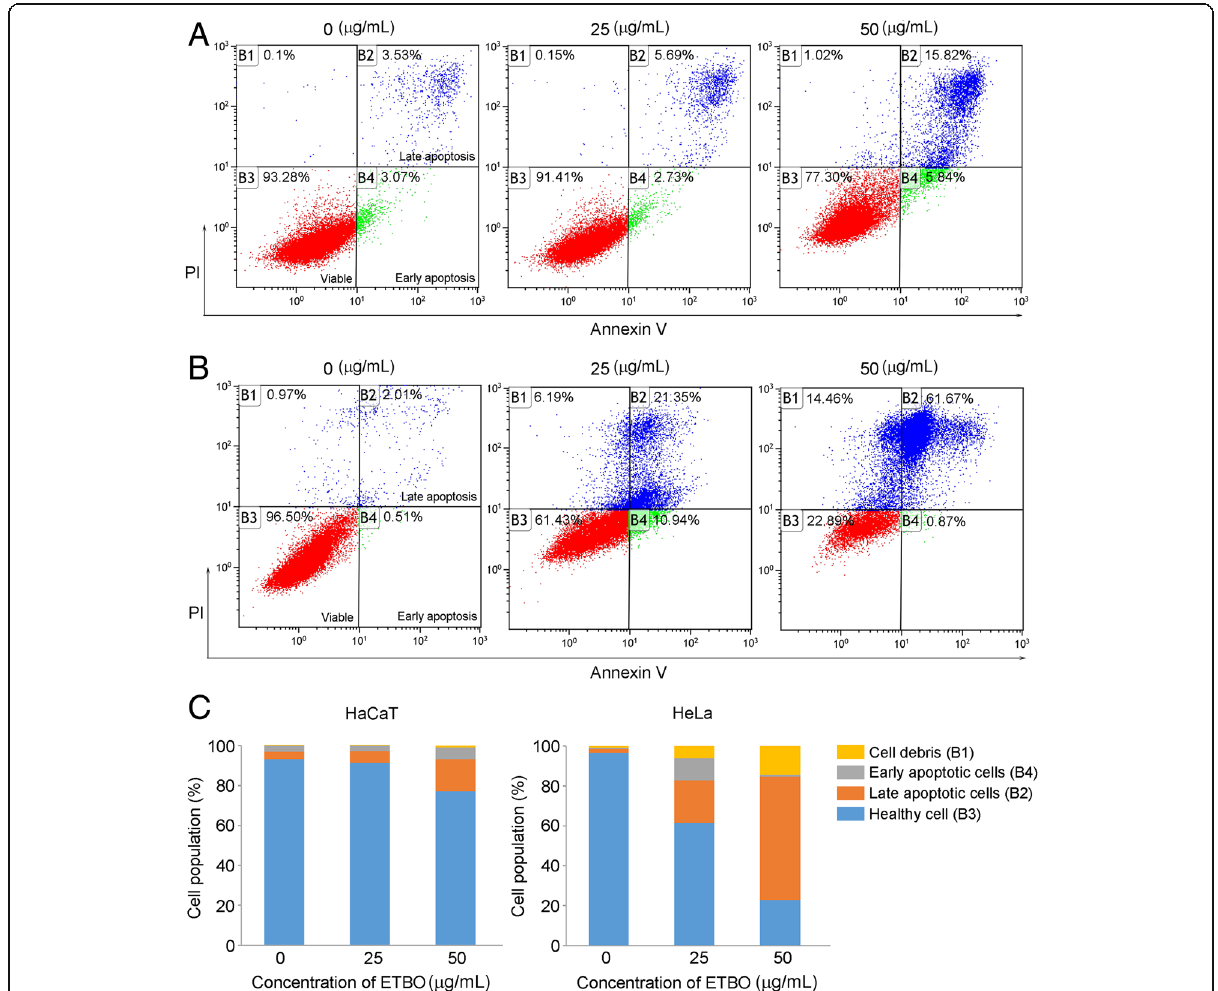
Fig. 4 Effect of ETBO on apoptosis. Normal (HaCaT) ( a ) and cancer (HeLa) cells ( b ) were treated with or without different concentrations (25 and 50 μ g/mL) of ETBO for 24 h. Cell population and the extent of apoptosis were measured by FACS analysis ( c ). ETBO, Ethanol extract of Botryidiopsidaceae sp.; FACS, fluorescence-activated cell